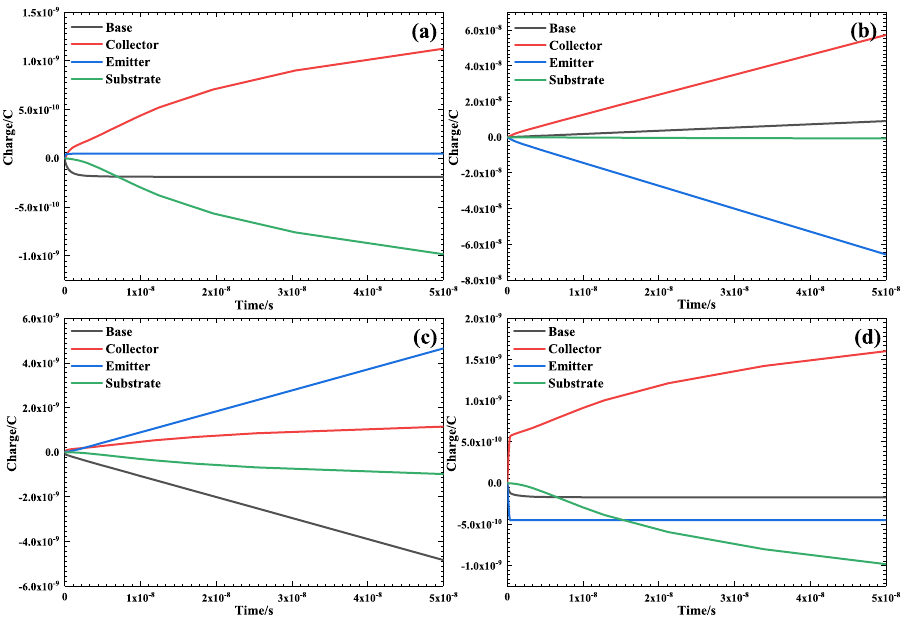
Figure A4. Change in collected charge with time when heavy ions vertically irradiate the emitter of the SiGe HBT under the substrate inverse bias ( a ), positive bias ( b ), off bias ( c ) and collector positive bias ( d )